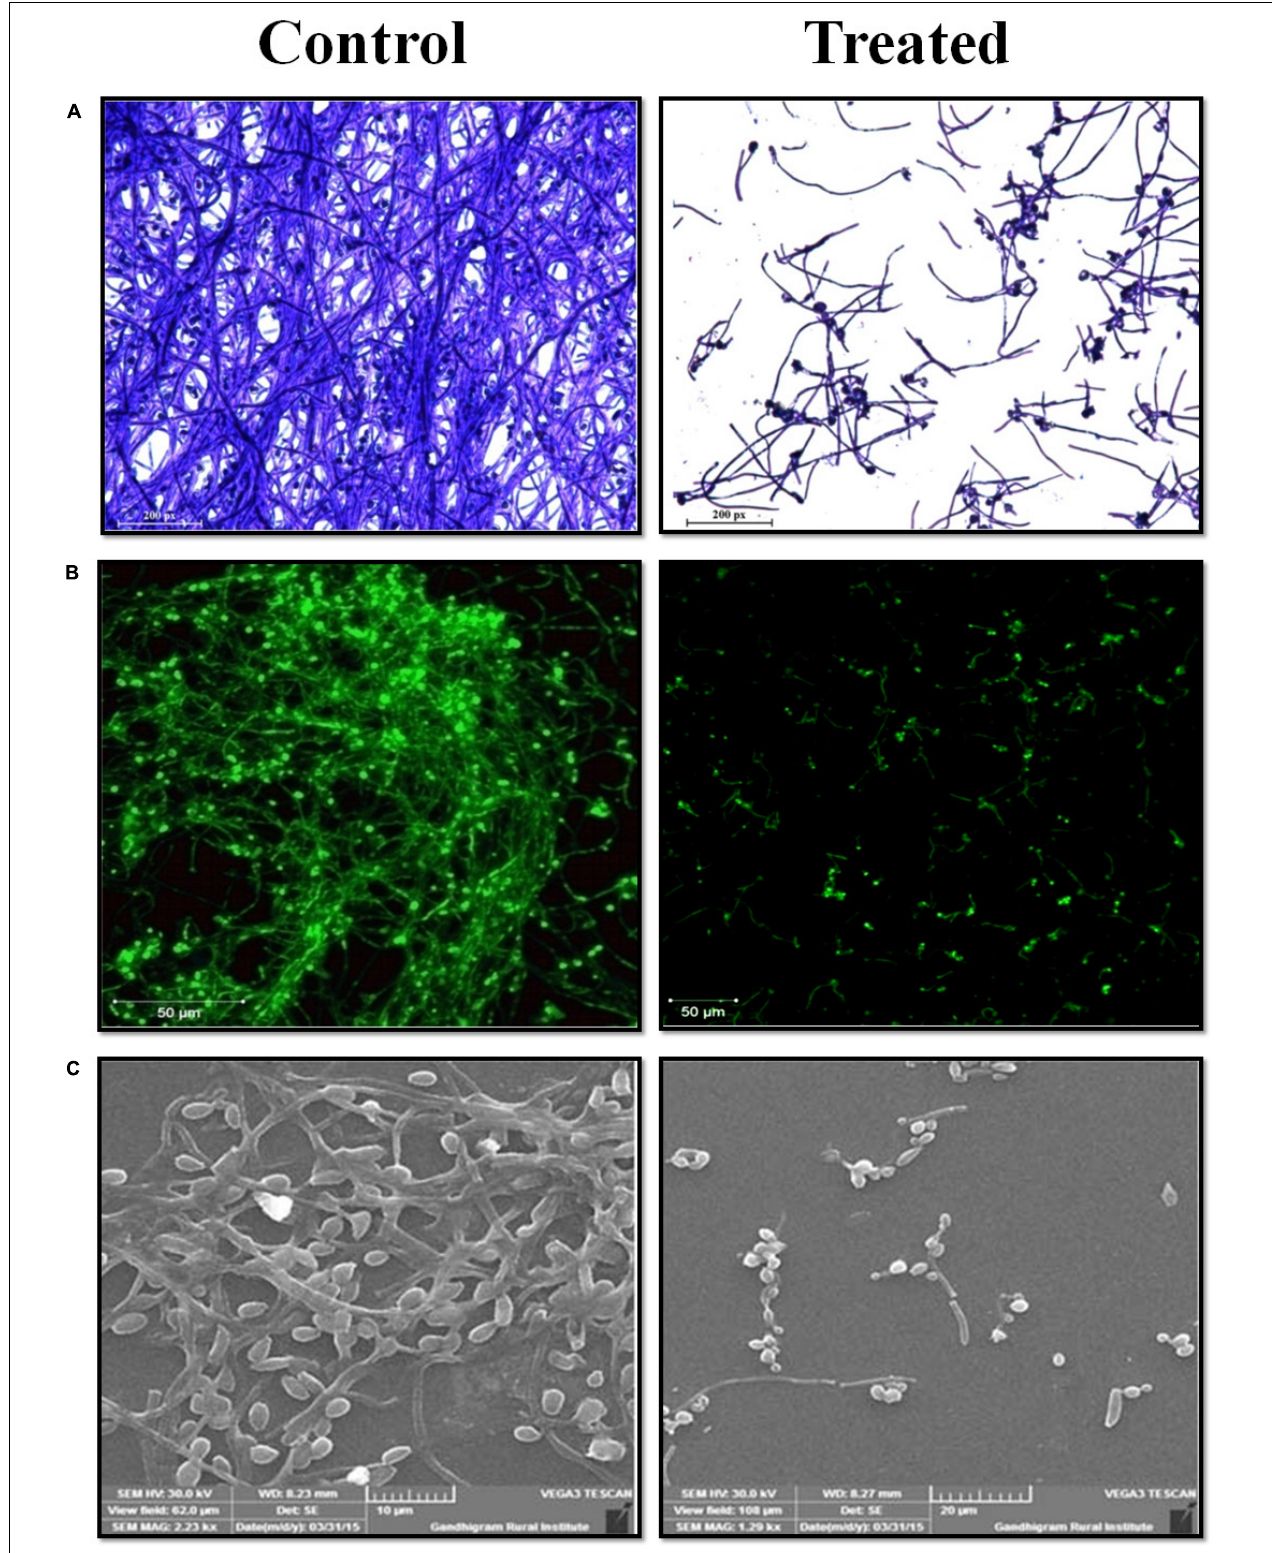
FIGURE 2 | Microscopic analysis of C. albicans biofilms in the absence and presence of morin at MBIC. (A) Light microscope. (B) Confocal laser scanning microscope. (C) Scaning electron microscope analysis.